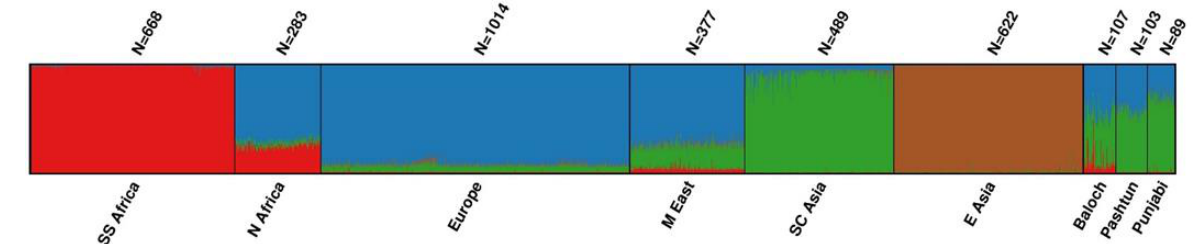
Figure 2. STRUCTURE analysis with K = 4 using 160 ancestry informative markers (AIMs) and six meta-populations. Each cluster (K) is represented by a color. Population abbreviations used: SS Africa: Sub-Saharan Africa; N Africa: North Africa; M East: Middle East; SC Asia: South-Central Asia; E Asia: East Asia.